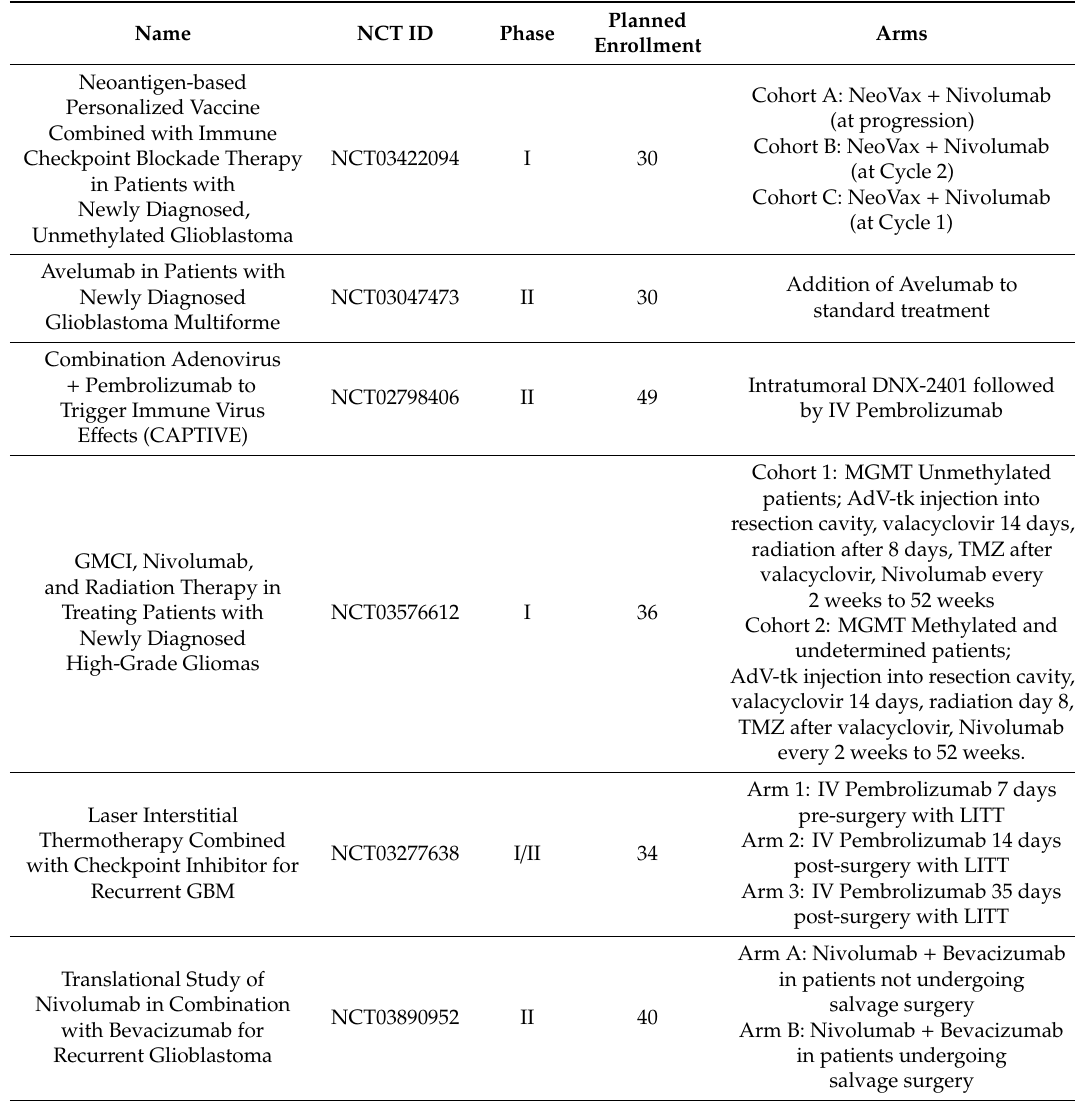
Table 2. Clinical trials investigating the use of ICIs for treatment of